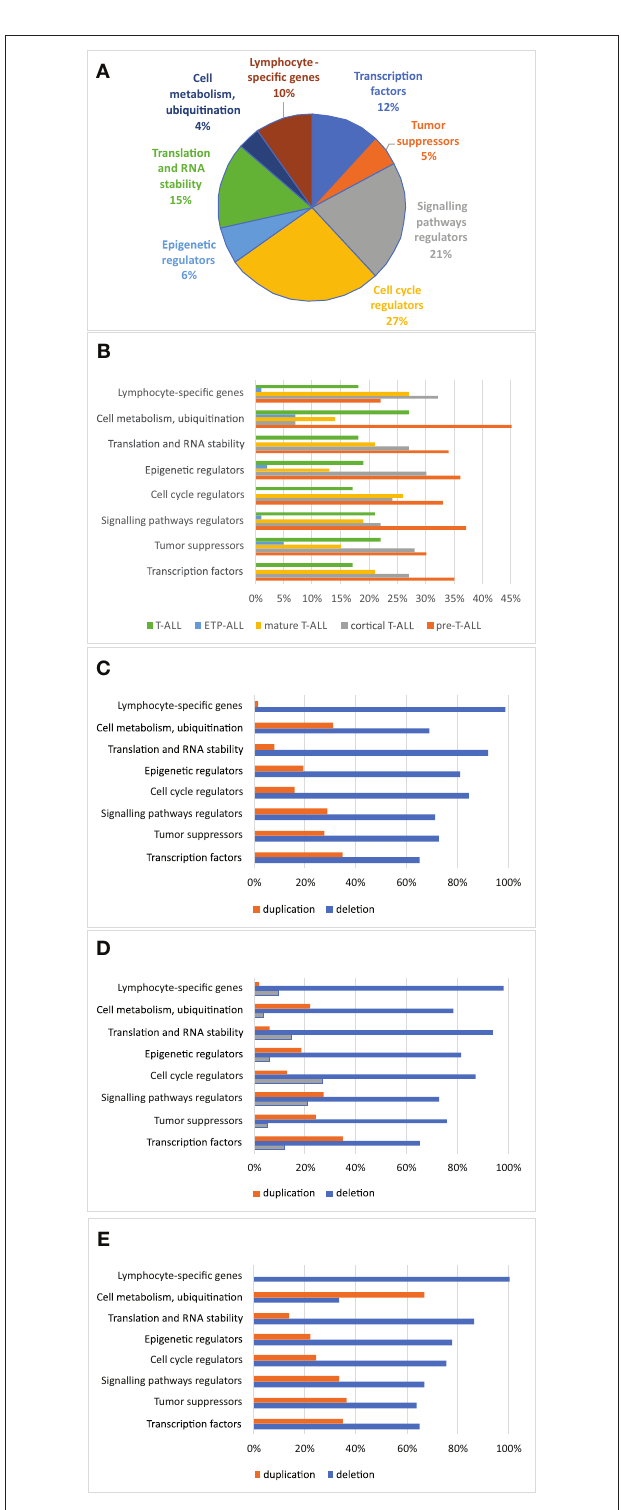
FIGURE 9 | Frequency of copy number alterations identified in 86 T-ALL cases. The incidence of CNAs relative to specific groups of genes (A) . Percentages of CNAs relative to specific groups of genes (B) . Percentages of CNAs relative to specific group of genes in the group of boys (C) , girls (D) , and all cases (E)